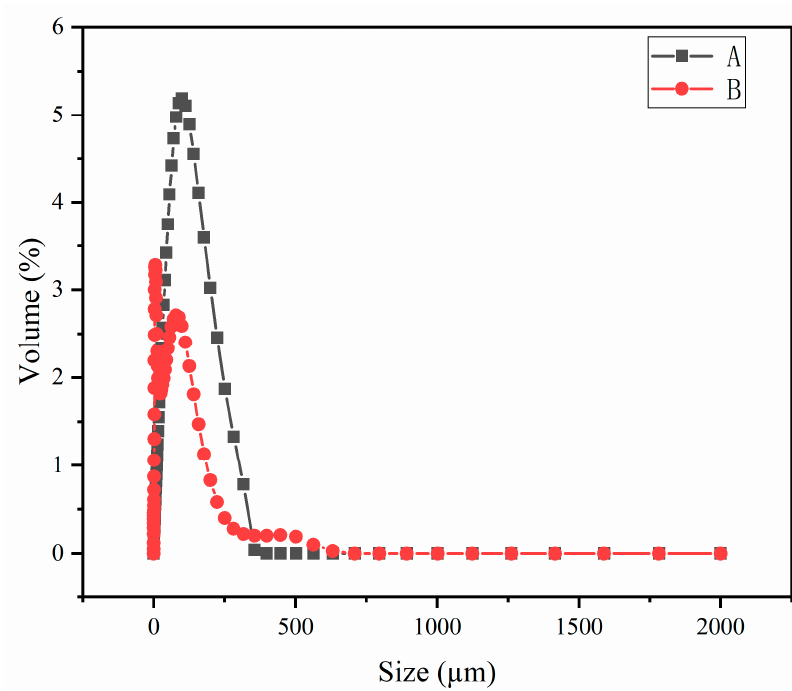
Figure 3. Particle size distribution of raw materials (( A )—PG, ( B )—CCS).